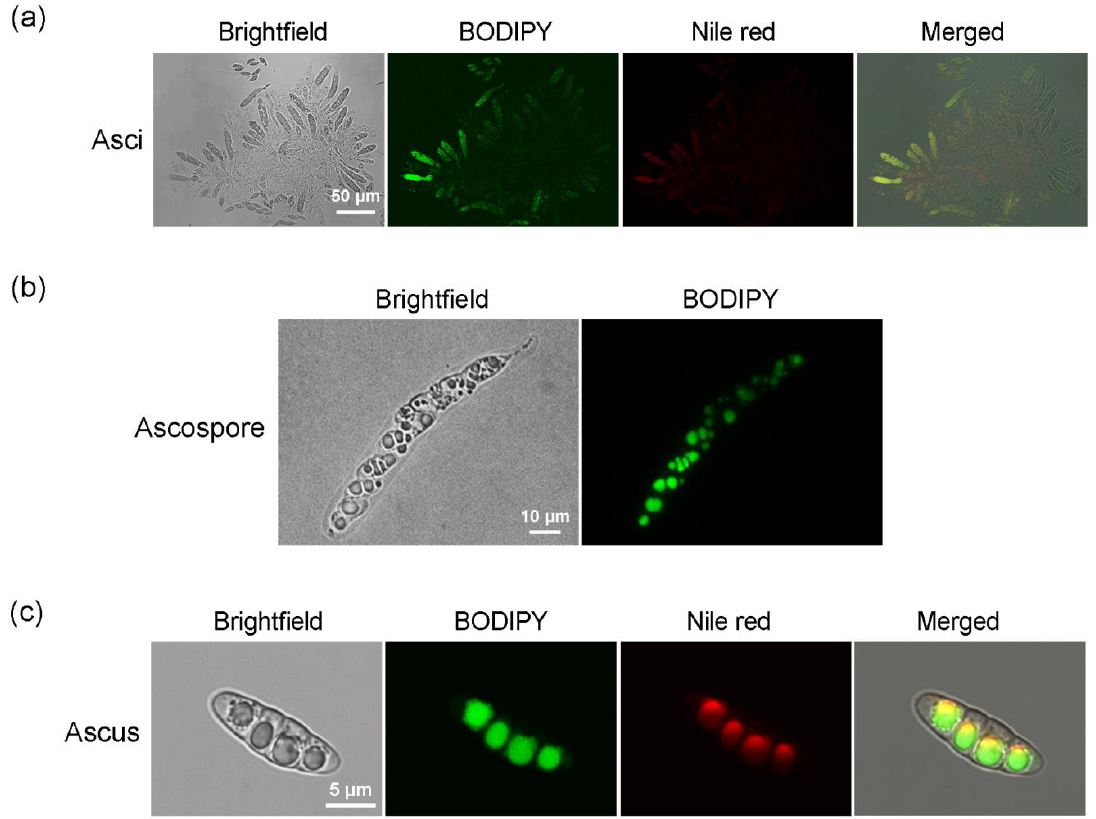
Figure 3. Staining of sexual structures of Magnaporthe oryzae with BODIPY and Nile red. M. oryzae strains Guy11 and 2539 were cross-cultured on OMA medium, and the asci and ascospores were stained with BODIPY and Nile red. ( a ) Asci in development; ( b ) A mature ascus, containing ascospores; ( c ) A mature ascospore.